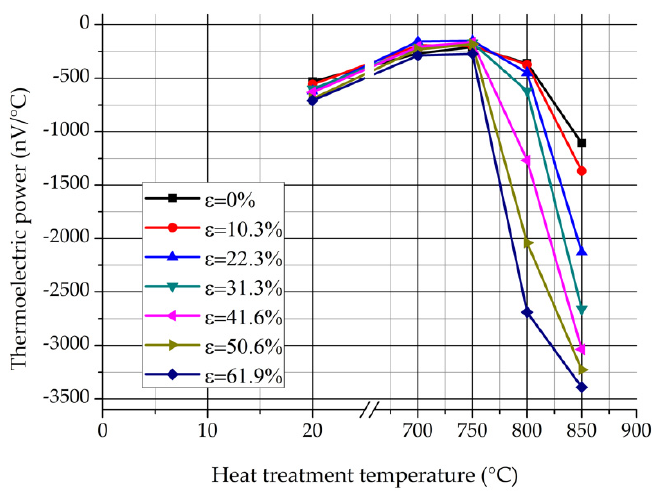
Figure 12. Values of the TEP in function of the heat treatment temperature.